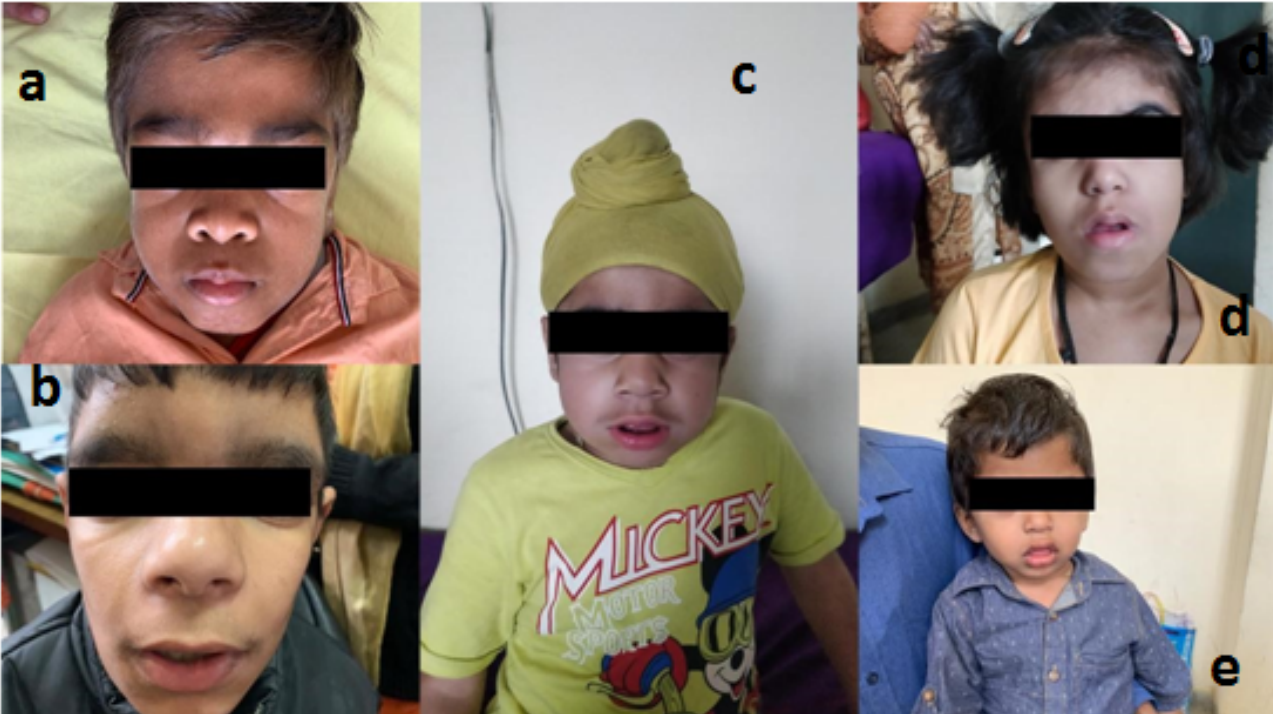
Figure 1. Facial profile of various MPS showing coarse facies, thick lips and open mouth: MPS II (1a, 1b, 1e); MPS I (1c); MPS IIIA (1d) (with